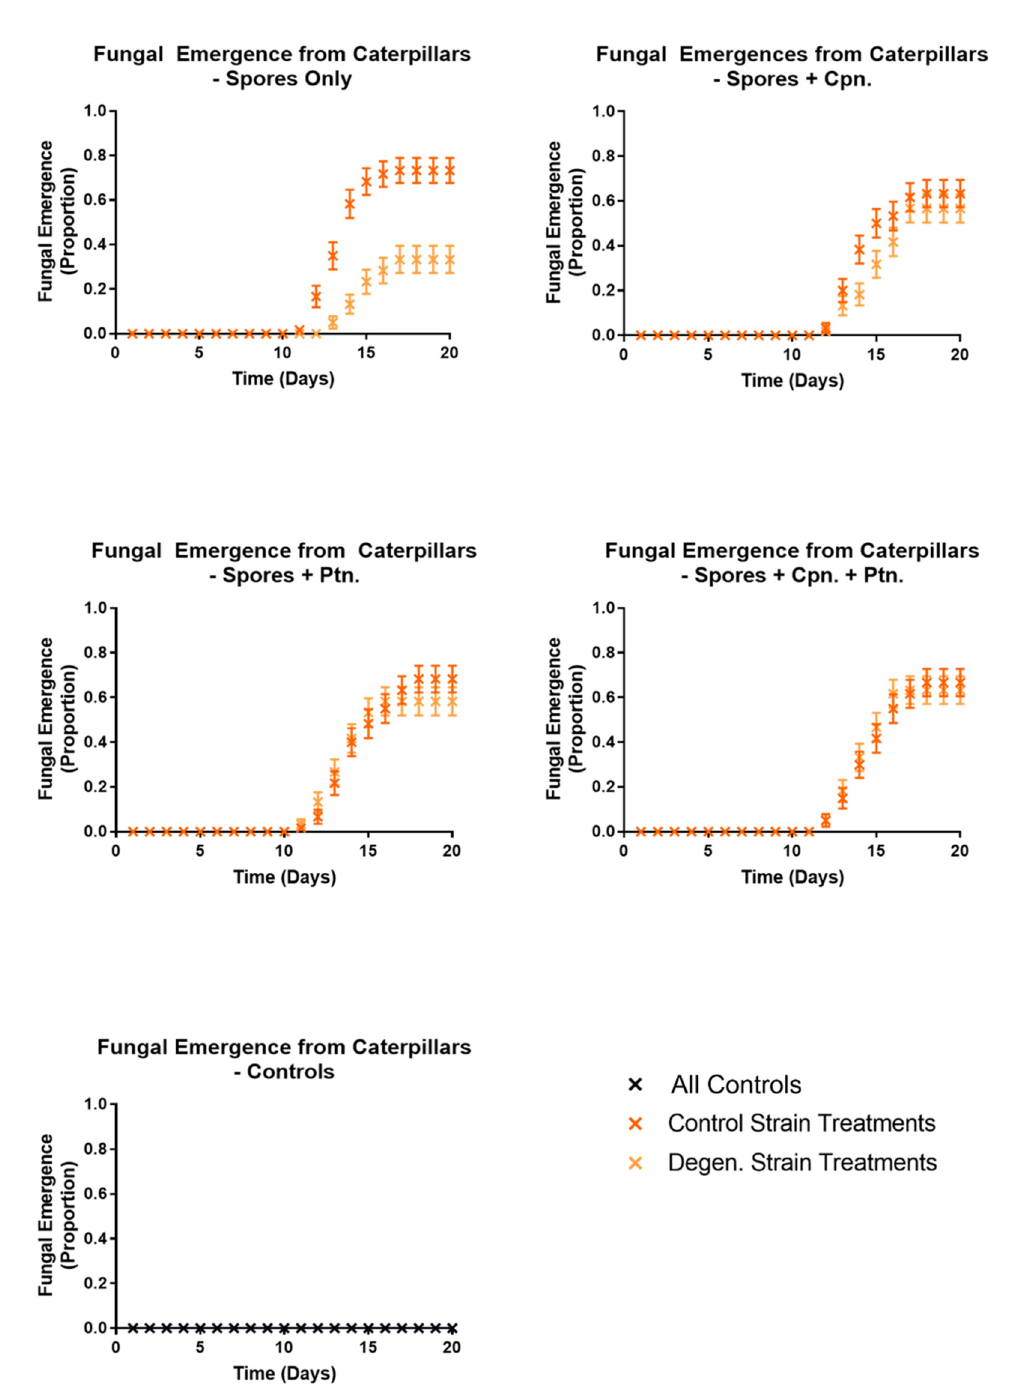
Figure 13. Proportions of fungal emergence observed in Galleria mellonella caterpillars following injections with washed C. militaris conidia, cordycepin and pentostatin—time course graphs. Results were recorded on a daily basis over a period of two weeks, following injection of PBS-washed conidia from CM2 potato dextrose broth cultures, with and without cordycepin and pentostatin, as well as controls. Sixty caterpillars were used in each treatment. Error bars show 95% confidence intervals. Abbreviations: cpn—cordycepin; ptn—pentostatin. Note the controls were control (uninjected), control (blank), control (needle), cordycepin only and pentostatin only—all with zero values. Responsiveness in control and degenerated strain-injected caterpillars was not sig- nificantly different, with or without cordycepin and pentostatin additions. All treatments involving spore injections had significantly lower responsiveness than their